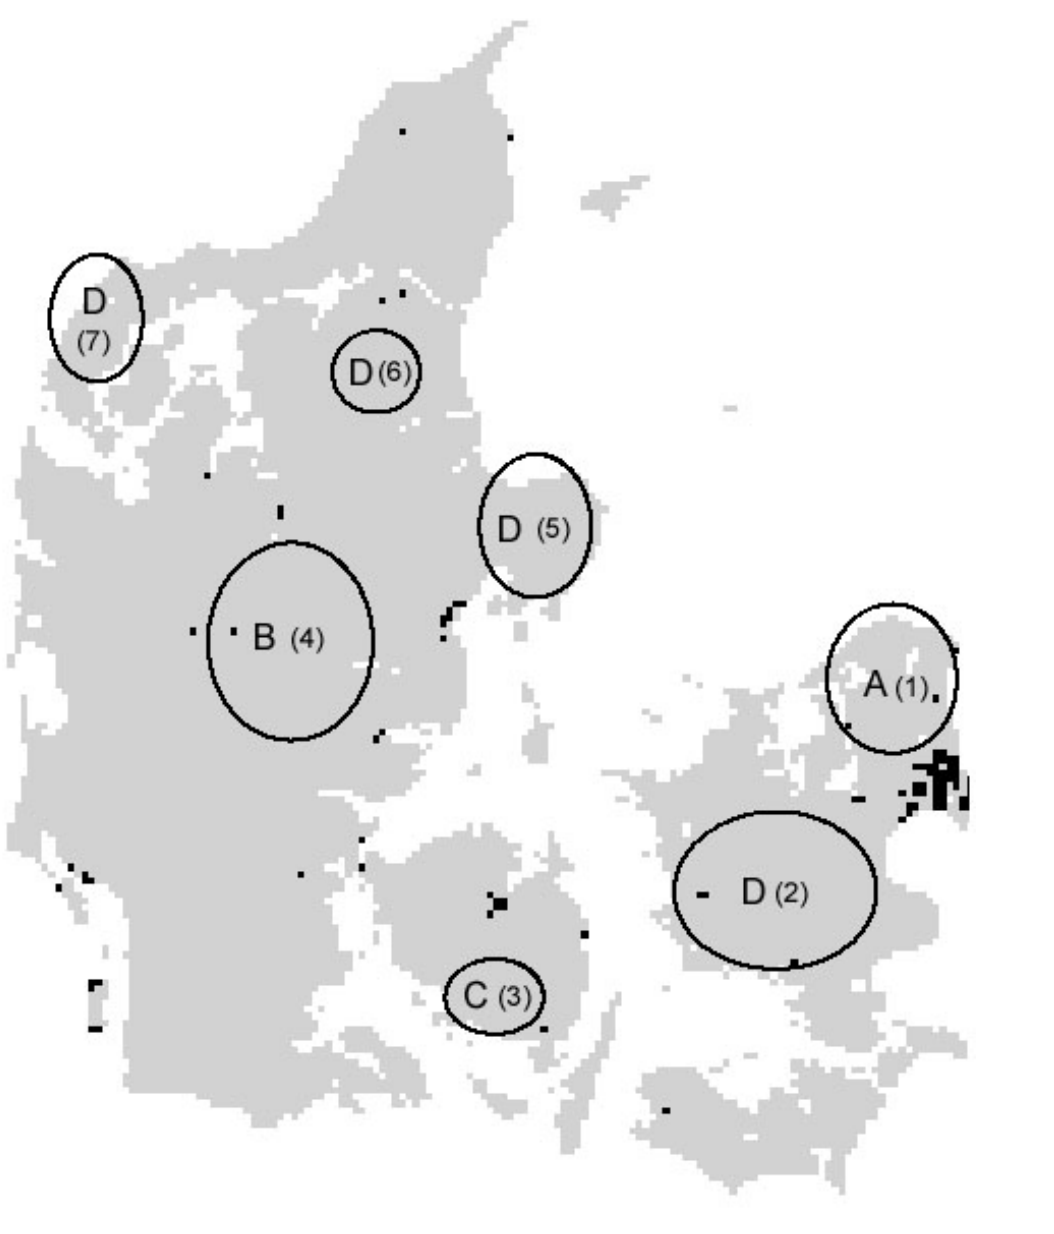
Fig. 6 . Classification of potential reintroduction areas in Denmark attending to the most restrictive habitat scenario for boar reintroduction success, i.e., high forest requirement, and the most pessimistic risk scenario, i.e., boars also expand and contact farms thorough areas with low forest cover. Area type: (A) high population expansion, high risk relative to the expansion; (B) high expansion, proportional risk; (C) low expansion, high relative risk; and (D) low expansion, proportional to low relative risk. Area: (1) North Sealand, (2) South Sealand, (3) Fynn Island, (4) Silkeborg Forest, (5) Djursland Peninsula, (6) Rold Forest, and (7)